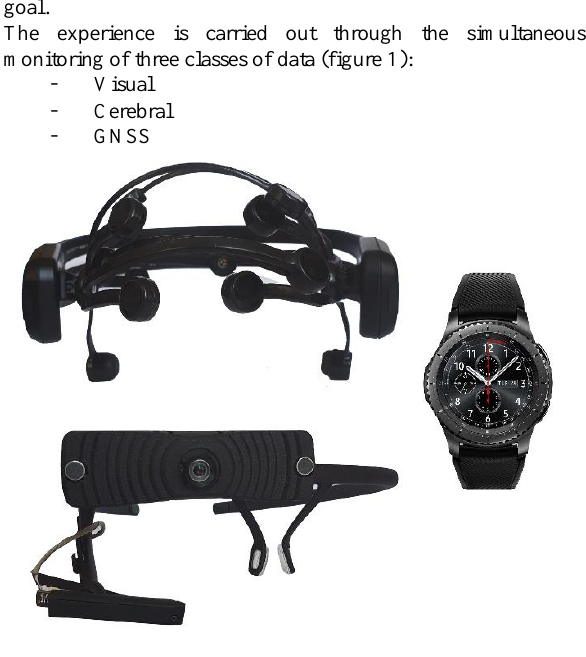
Figure 2. Tools used for data